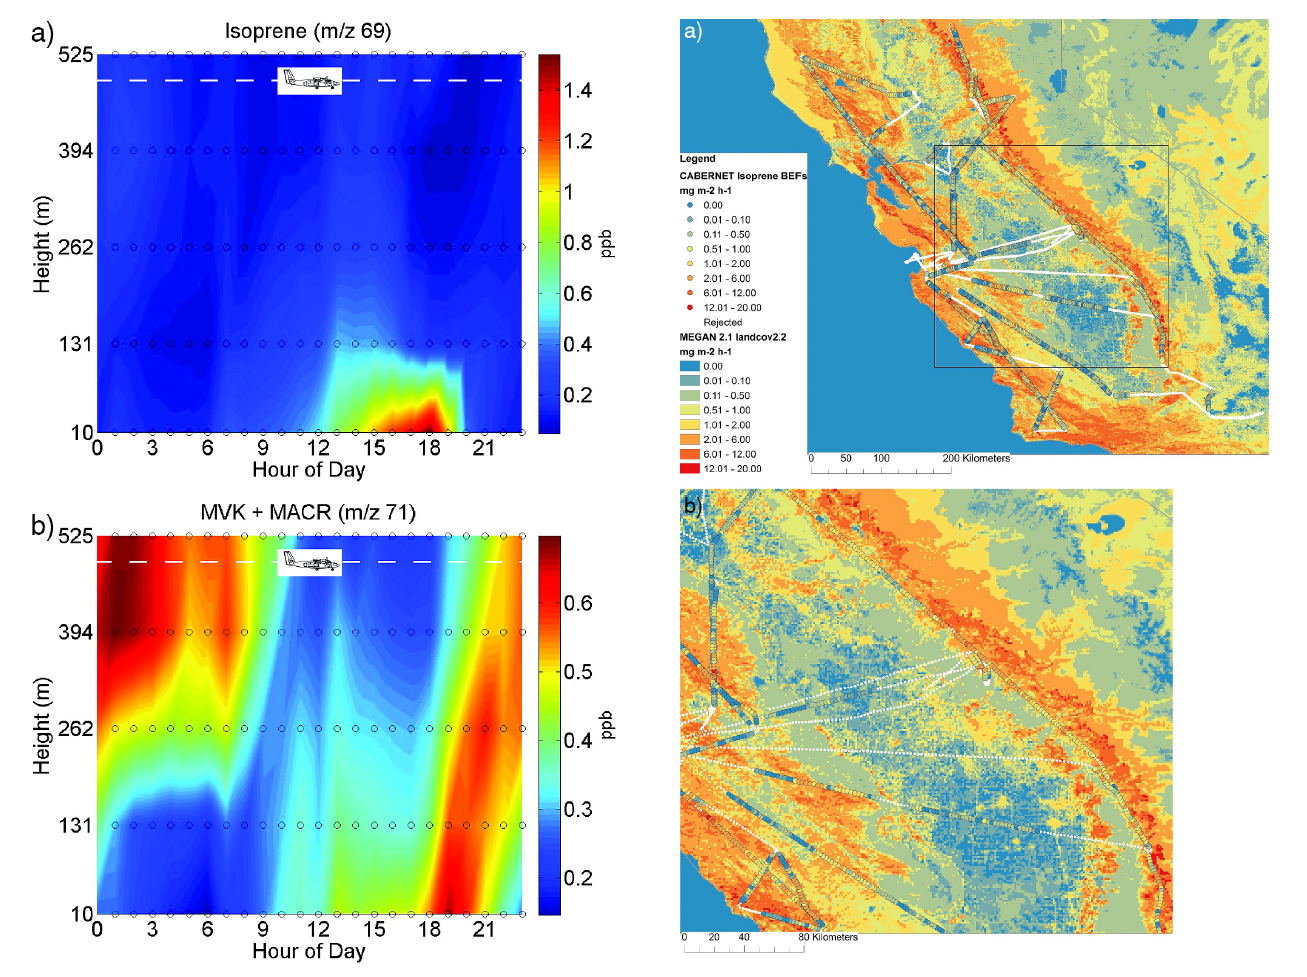
Figure 6. Concentration gradients at Walnut Grove tower for (a) m/z 69 (isoprene) and (b) m/z 71 (dominated by MVK + MAC). The open circles denote the sampling heights. When the aircraft was passing the tower both the tower’s top two inlet levels and the air- craft observed very low but non-zero concentrations of isoprene and MVK + MAC. However, the tower data demonstrate that oxidation products of isoprene routinely accumulate at night in the residual layer due to transport from the surrounding foothills where emis- sions are high. The ground-airborne intercomparison is shown in the Supplement and Supplement Fig. S3.